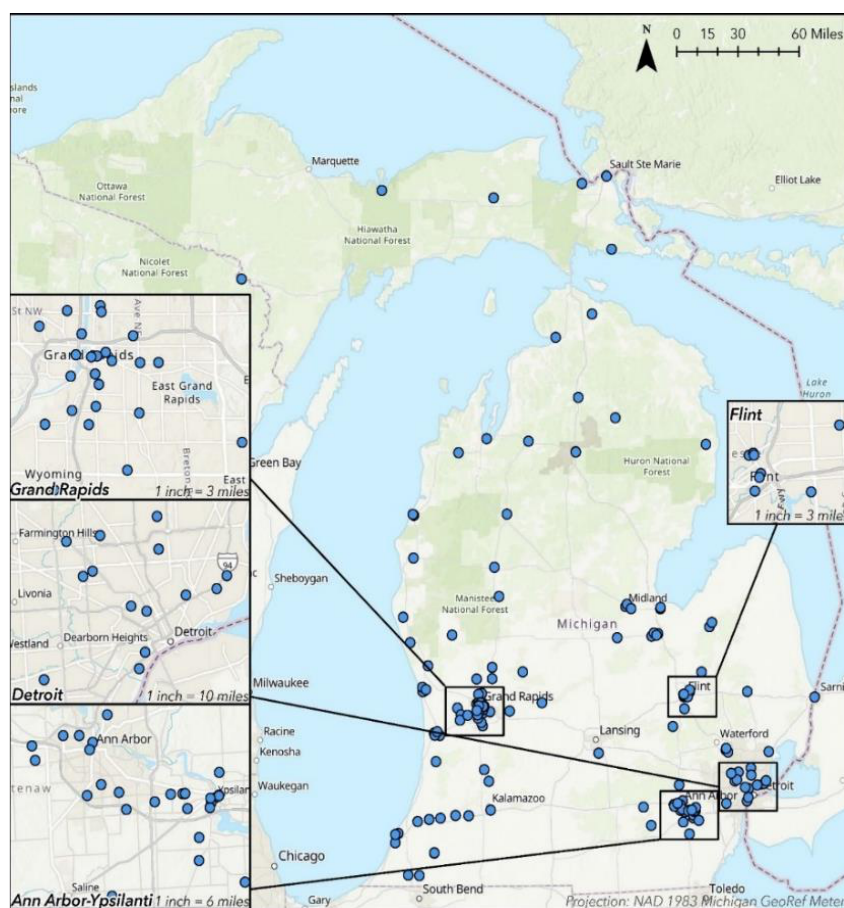
Figure 1. Location of Emergency Food Assistance Organizations